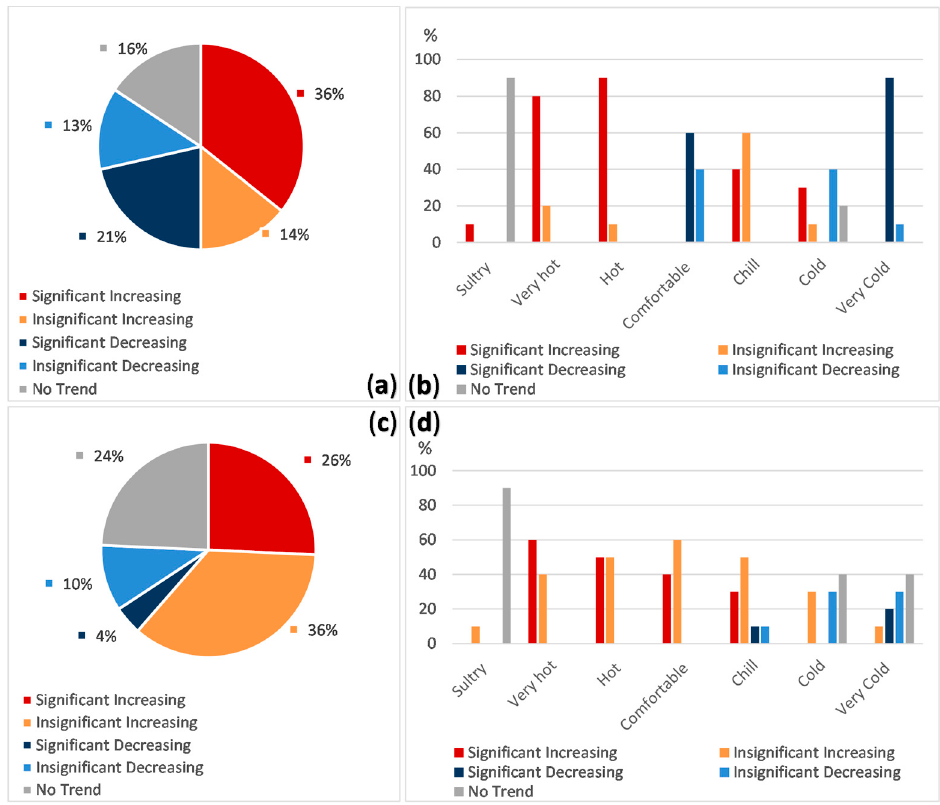
Figure 15. Trend types for the THI index: ( a ) for all data sets of FO; ( b ) by thermal sensations classes of FO; ( c ) for all data sets of DOP; ( d ) by thermal sensations classes of DOP.